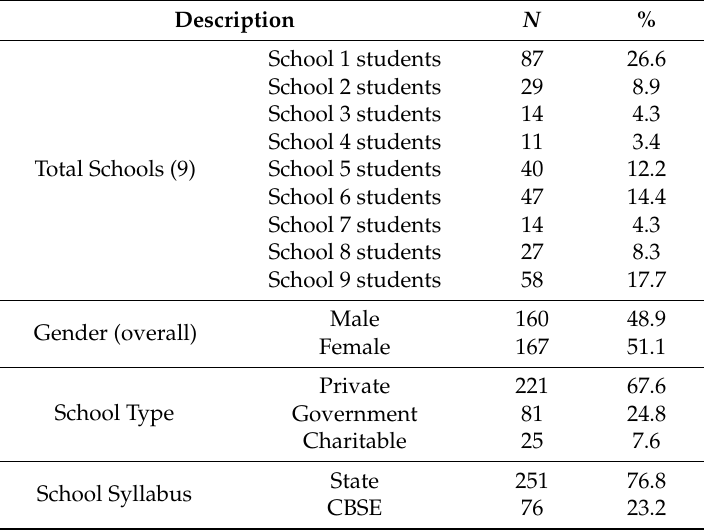
Table 1. Descriptive of students and school demographic data.